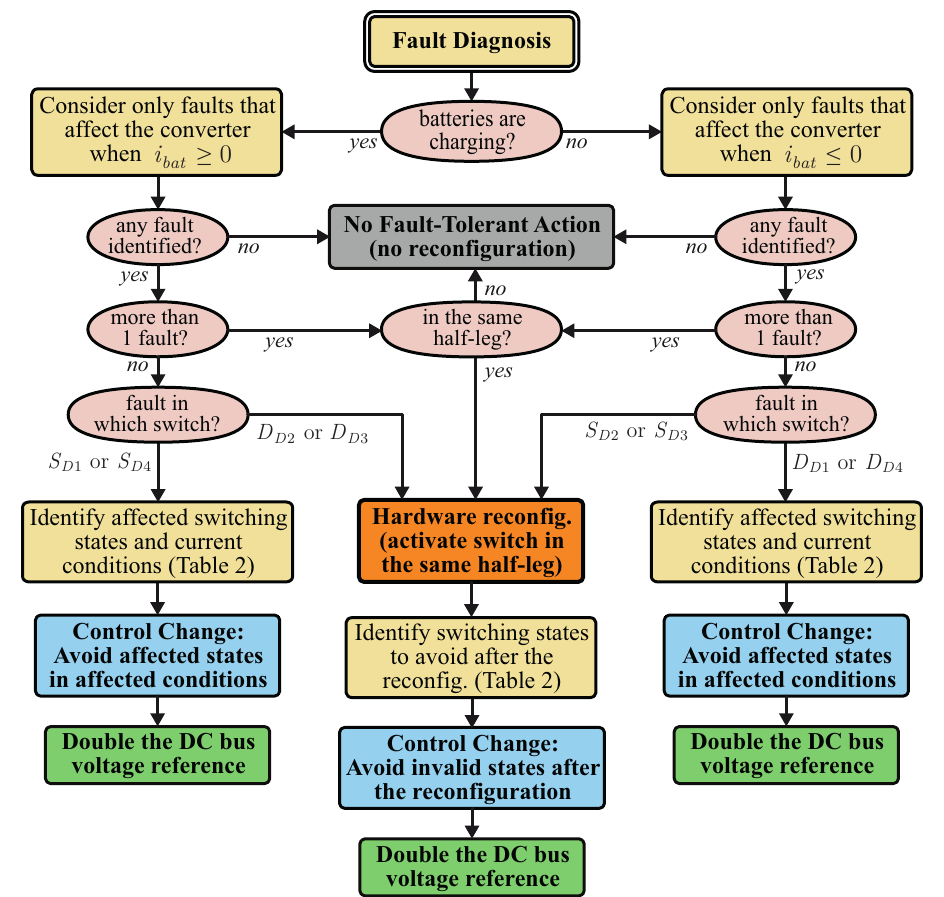
Figure 10. Flowchart of the decision process for fault-tolerant action in the 3LDC converter, with minimal hardware